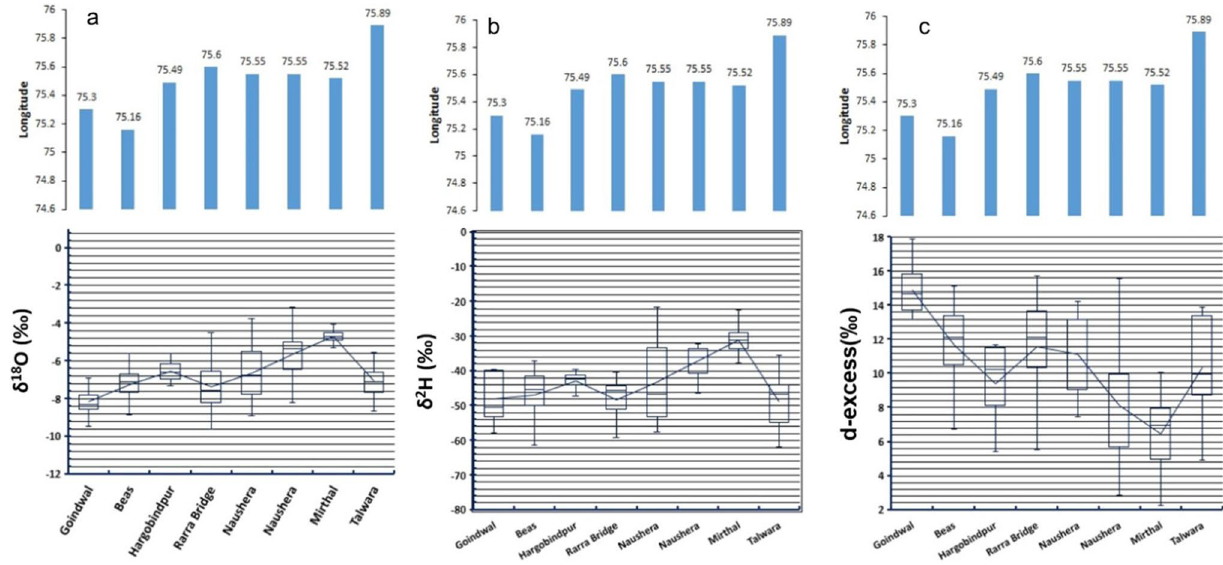
Fig. 8 The box and whisker plot diagram of a δ 18 O, b δ 2 H, and c d-excess for Beas river